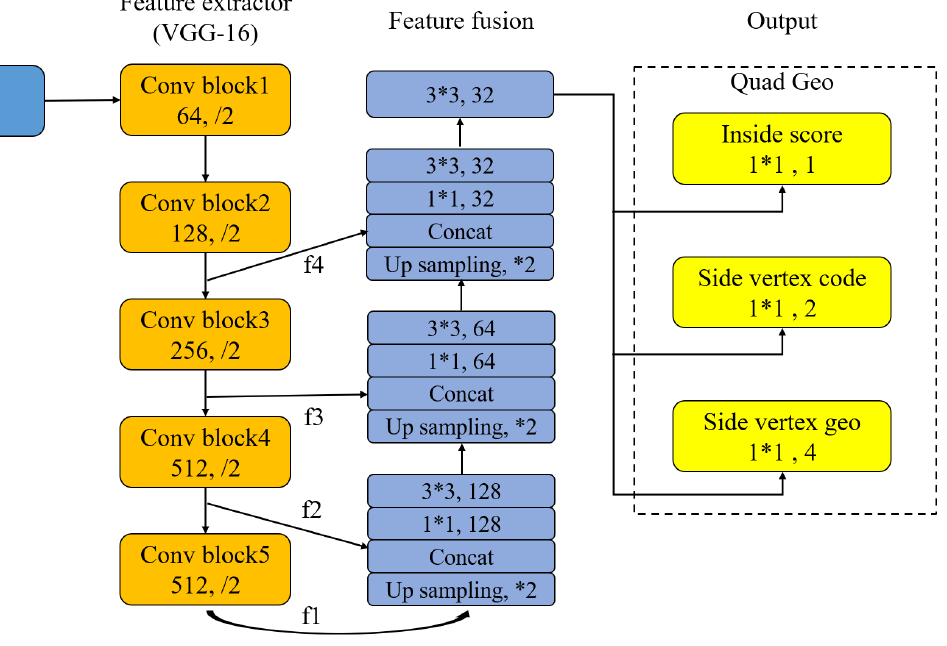
Figure 7. The network structure of FCN.